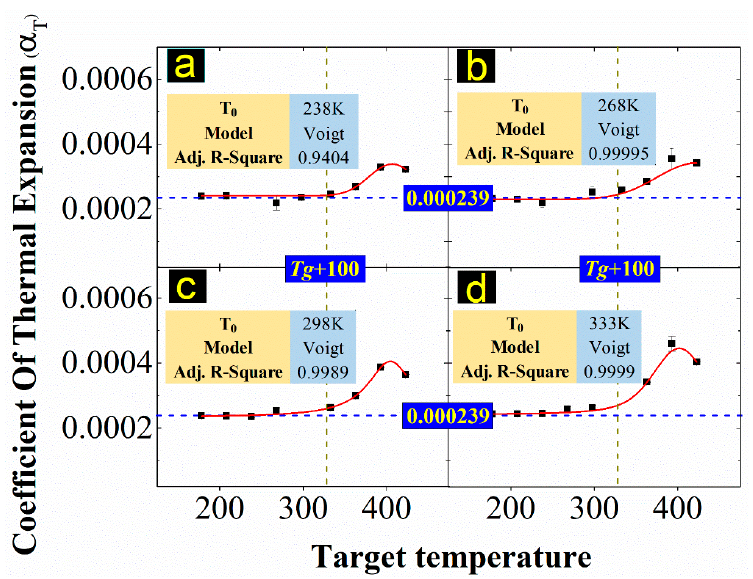
Figure 10. Thermal expansion coefficient: T 0 is the reference temperature and T g is the glass transition temperature; ( a – d ) show the coefficient of thermal expansion at reference temperatures of 238, 268, 298, and 333 K, respectively. The results were fitted by the Voigt model.